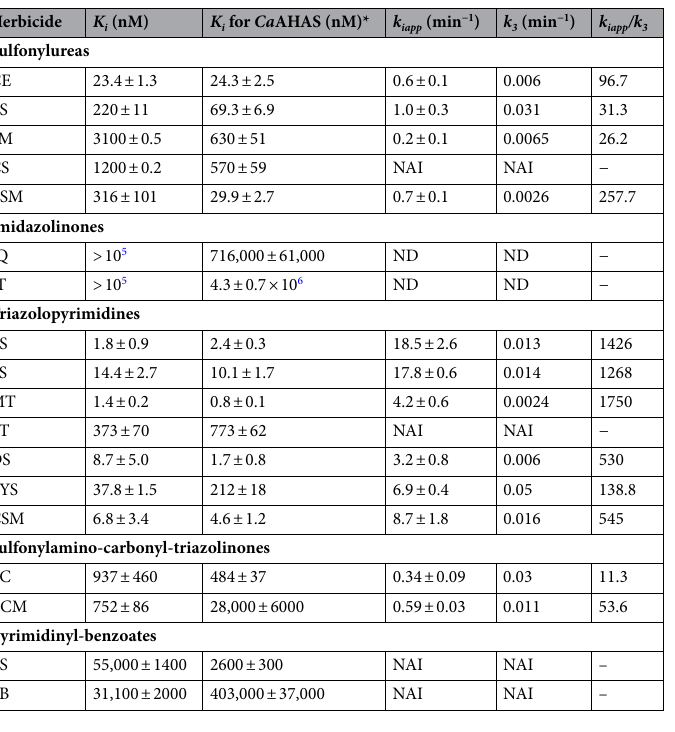
Table 1. Apparent first-order rate of inhibition ( k iapp ), first-order rate of enzyme recovery ( k 3 ), and inhibition constants ( K i ) of the commercial herbicides for Afu AHAS. * K i values for Ca AHAS are shown for comparison were obtained from Garcia et al. 13 . NAI No reversible accumulative inhibition observed, ND Not determined. See Fig. 1 for chemical structures of compounds.